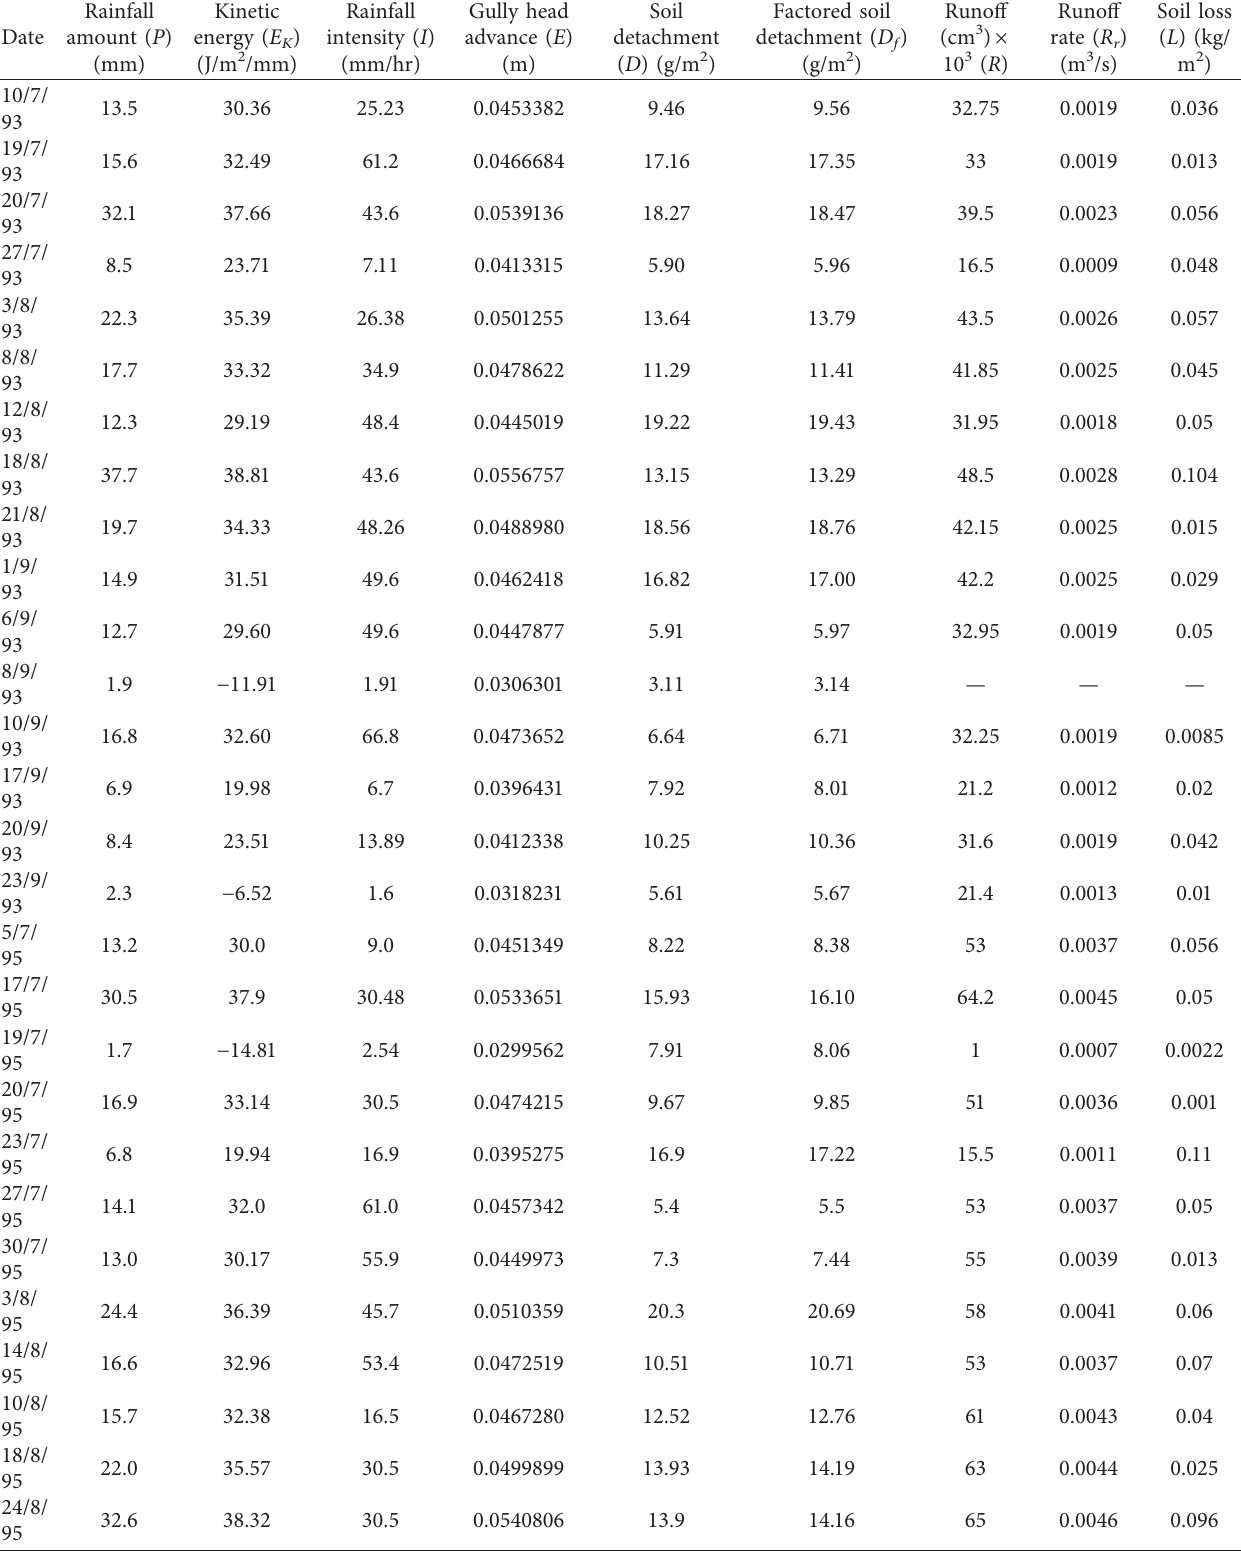
Table 1: Measurement and computation of rainstorm parameter day by day for 1993, 1995, and 1996 seasons over bare soil